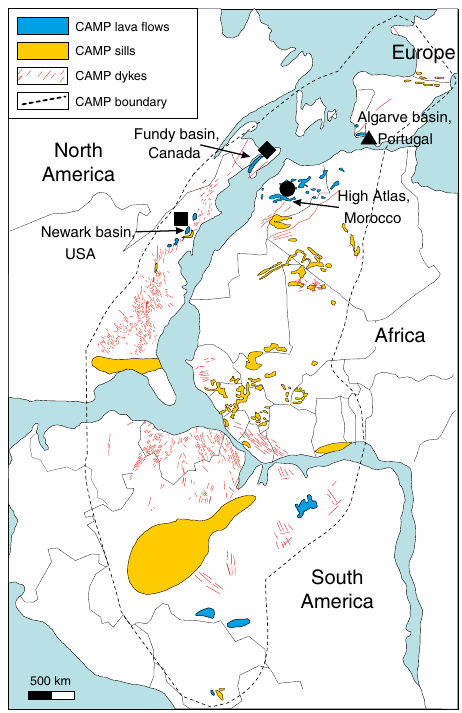
Fig. 1 Map of CAMP in central Pangea at about 200 Ma. The black symbols indicate the provenance of the studied samples: triangle for Portugal, circle for Morocco, square for New Jersey, USA, and diamond for Nova Scotia, Canada. The fi gure is modi fi ed after ref. 23